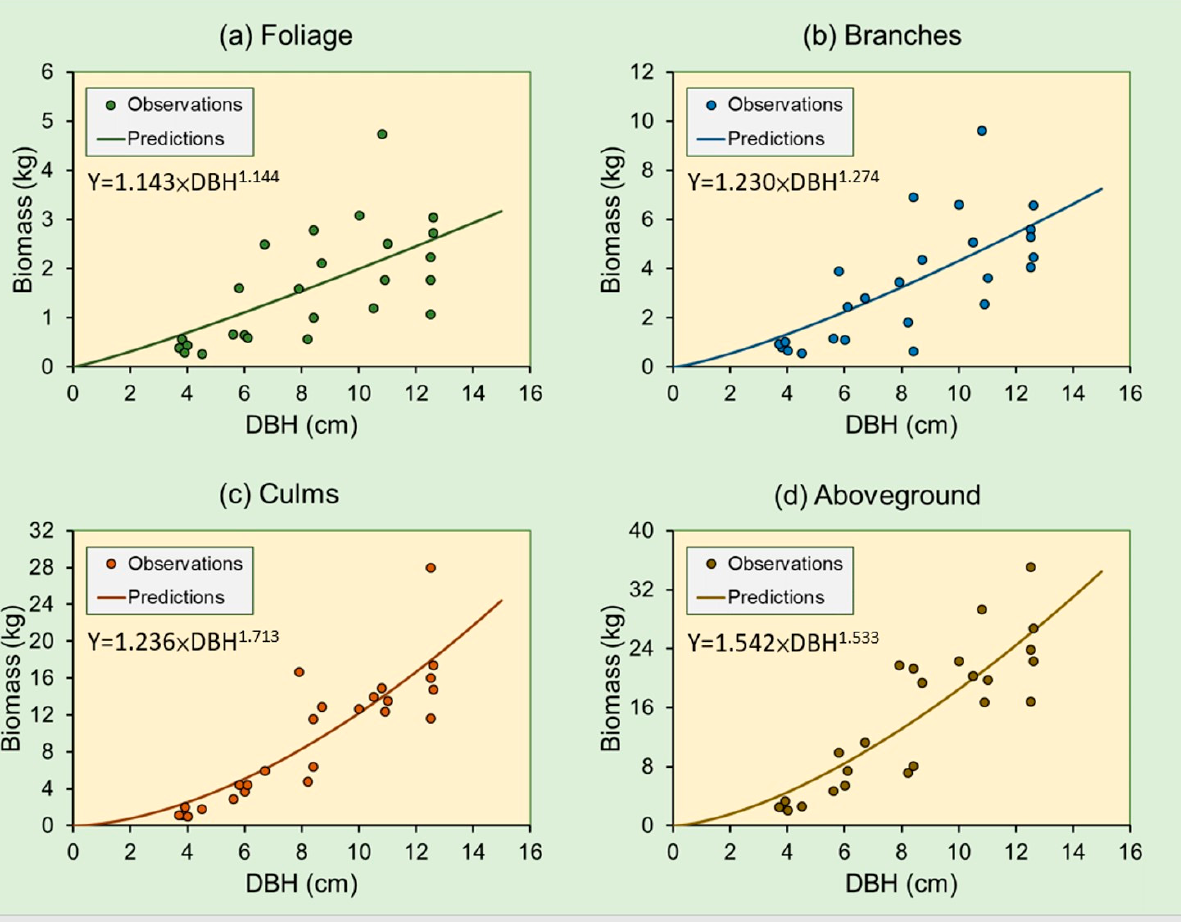
Figure 2. Relationships between observations and predicted curves by the allometric function ( Y = a × DBH b ) for the biomass of di ff erent sections of Ma bamboo.